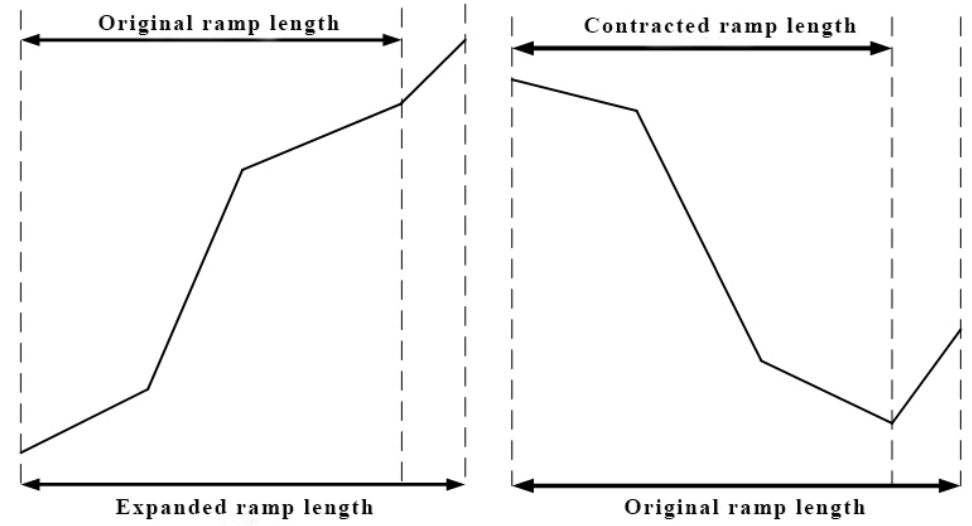
Figure 3. The principle of the ramp length extension and contraction strategy of conventional single ramp wind shear detection algorithm.